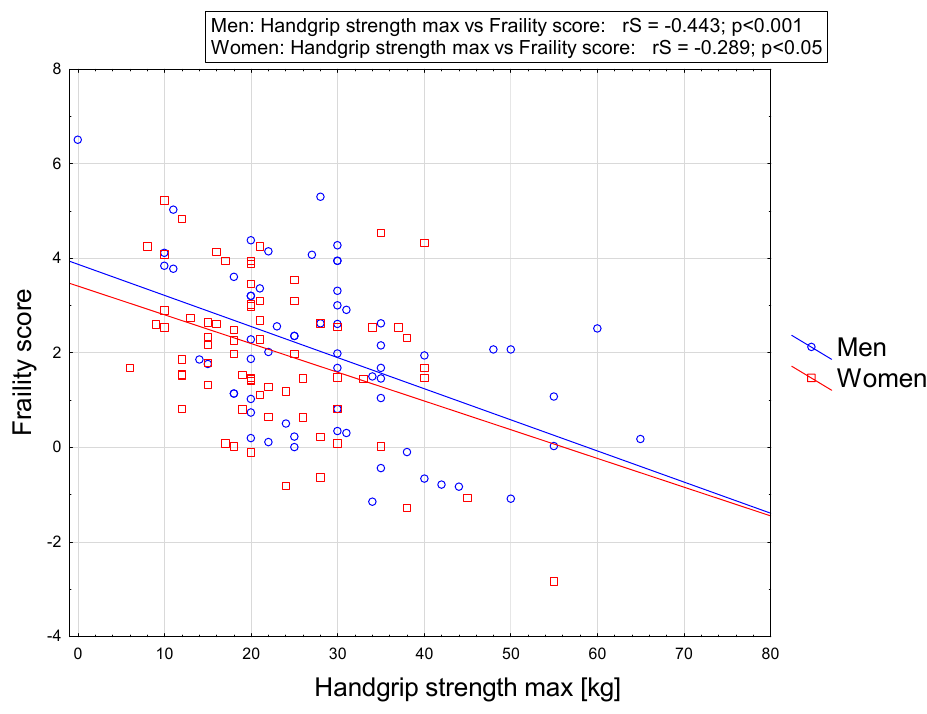
Figure 2. Relationship between HGS max. and frailty score in men and women. Table 4. The odds ratio of FS occurrence in one-way analysis for selected variables. Odds ratios obtained in one-factor analysis are presented in Table 4. Quantitative